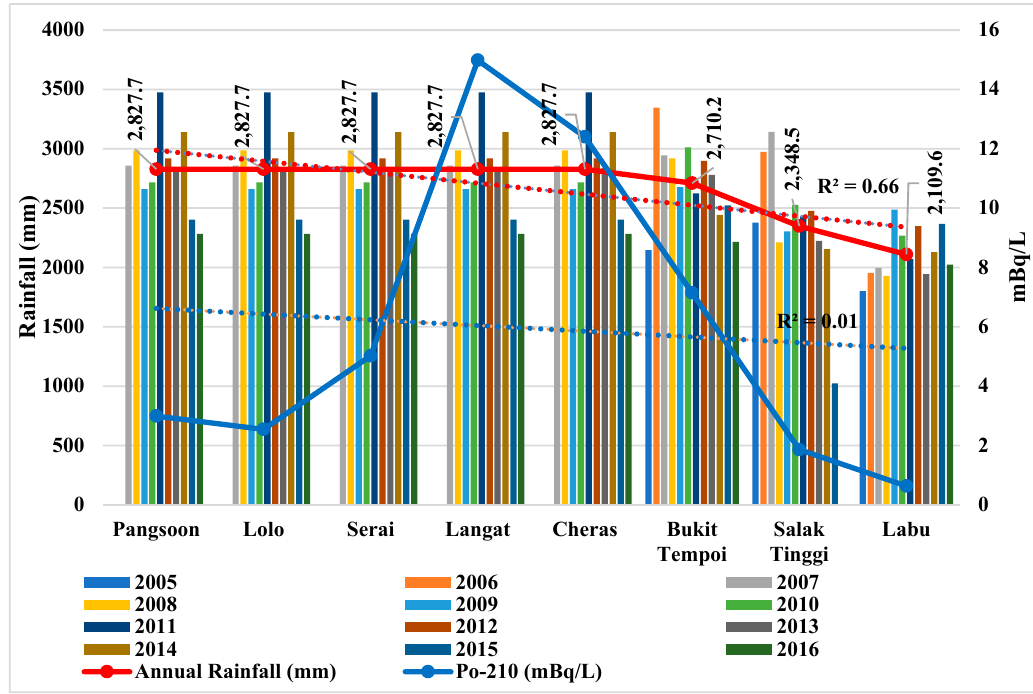
Figure 5. Po-210 activity in Langat River in relation with water flow in the Langat River. Note: Average water flow data (2005–2015) are from the Dept. of Drainage and Irrigation Malaysia. R² indicates the variance that is explained by the best-fit line from the upstream to the downstream of the Langat River.